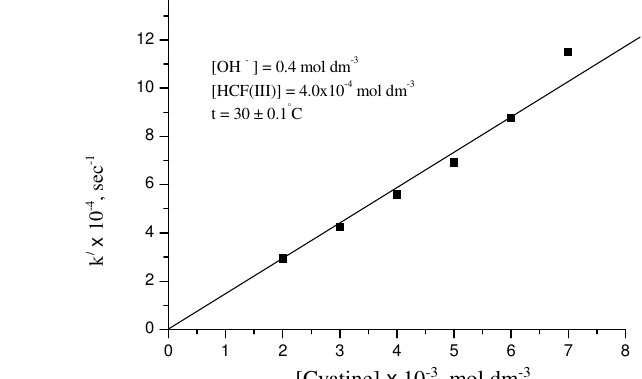
Figure 2. Order with respect to